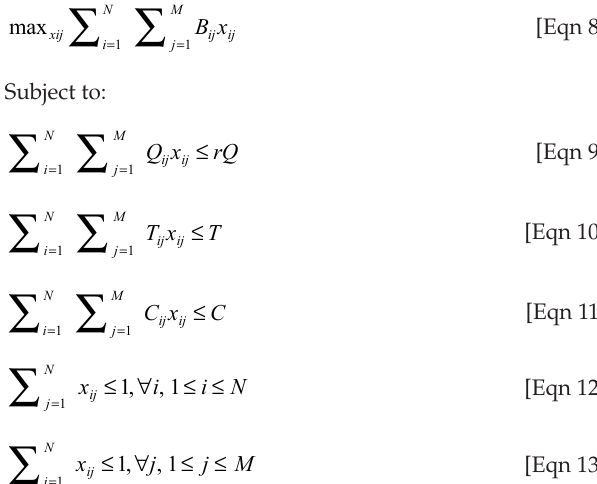
FIGURE 8: Plot of B